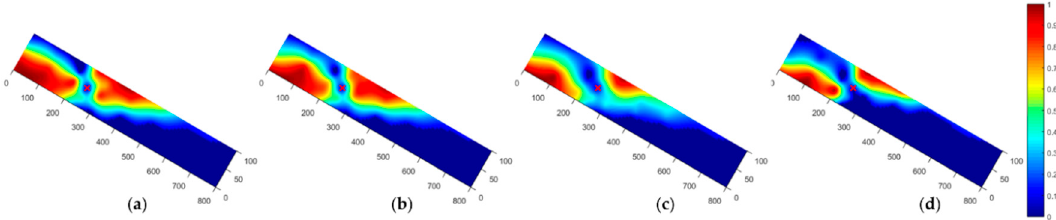
Figure 12. The oil distribution of different models after the development: ( a ) oil distribution of Exp1; ( b ) oil distribution of Exp2; ( c ) oil distribution of Exp3; ( d ) oil distribution of Exp4.